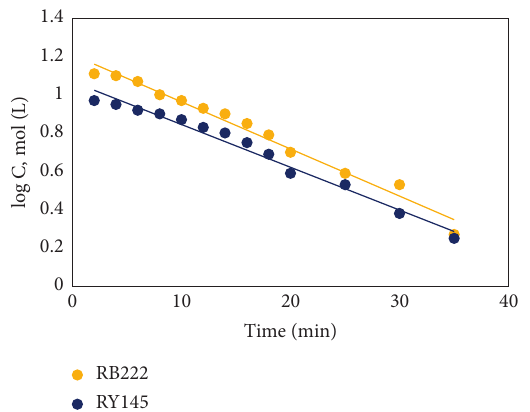
RB222 Figure 15: First-order kinetic for extraction of RY145 and RB222 dyes at concentration 6 × 10 − 5 mol/10ml by CTAB surfactant concentration 9 × 10 − 2 mol/10 ml.